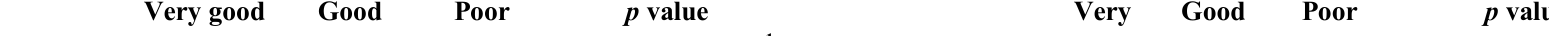
Very Good Poor p value good (Kendall’s tau b)